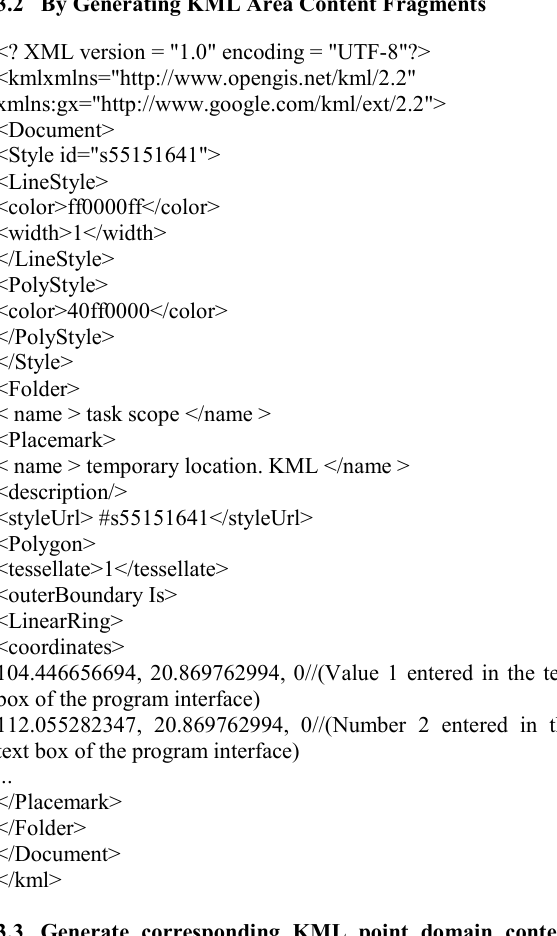
Figure 2. Then the KML area file is programmed and imported